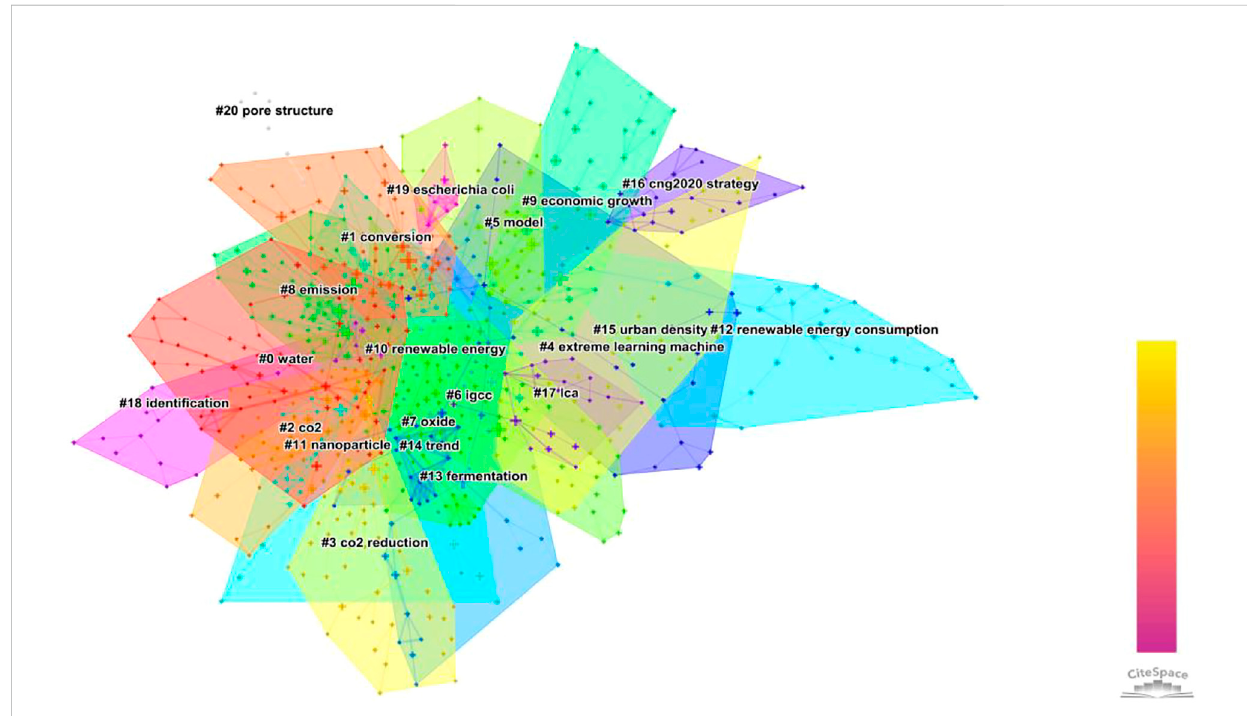
FIGURE 5 Keyword clustering